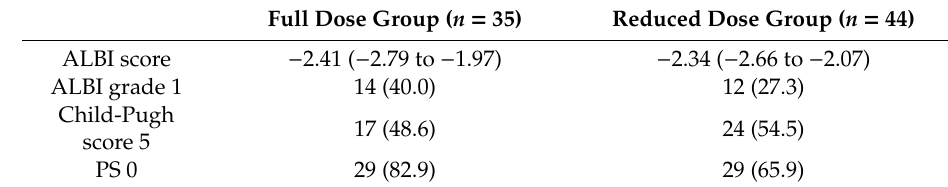
Table 7. Relationship between the initial dose and liver function and between the initial dose and PS ( n =